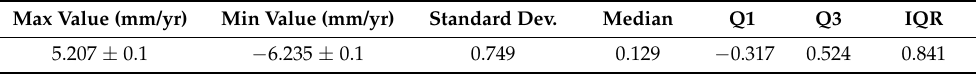
Table 5. Statistical values calculated for Vertical Velocities points in the whole study area. Max and Min values are the Maximum (positive) and Minimum (negative) velocities with their relative accuracy. The Standard dev. column is the population standard deviation of the data. The median is the value in the middle of the data set. Q1 and Q3 are respectively the lower and the upper quartiles and the IQR is the Inter Quartile Range, a measure of statistical